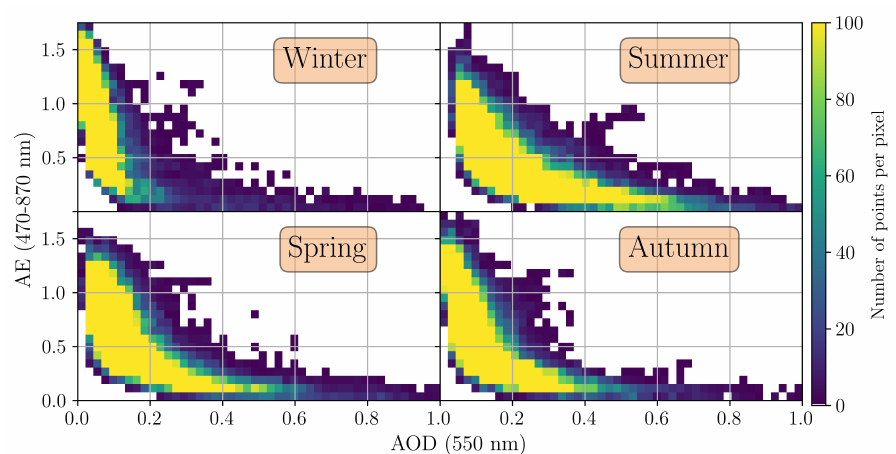
Figure A3. Density number plot between MERRA-2 AOD and AE (2002–2020) per season over